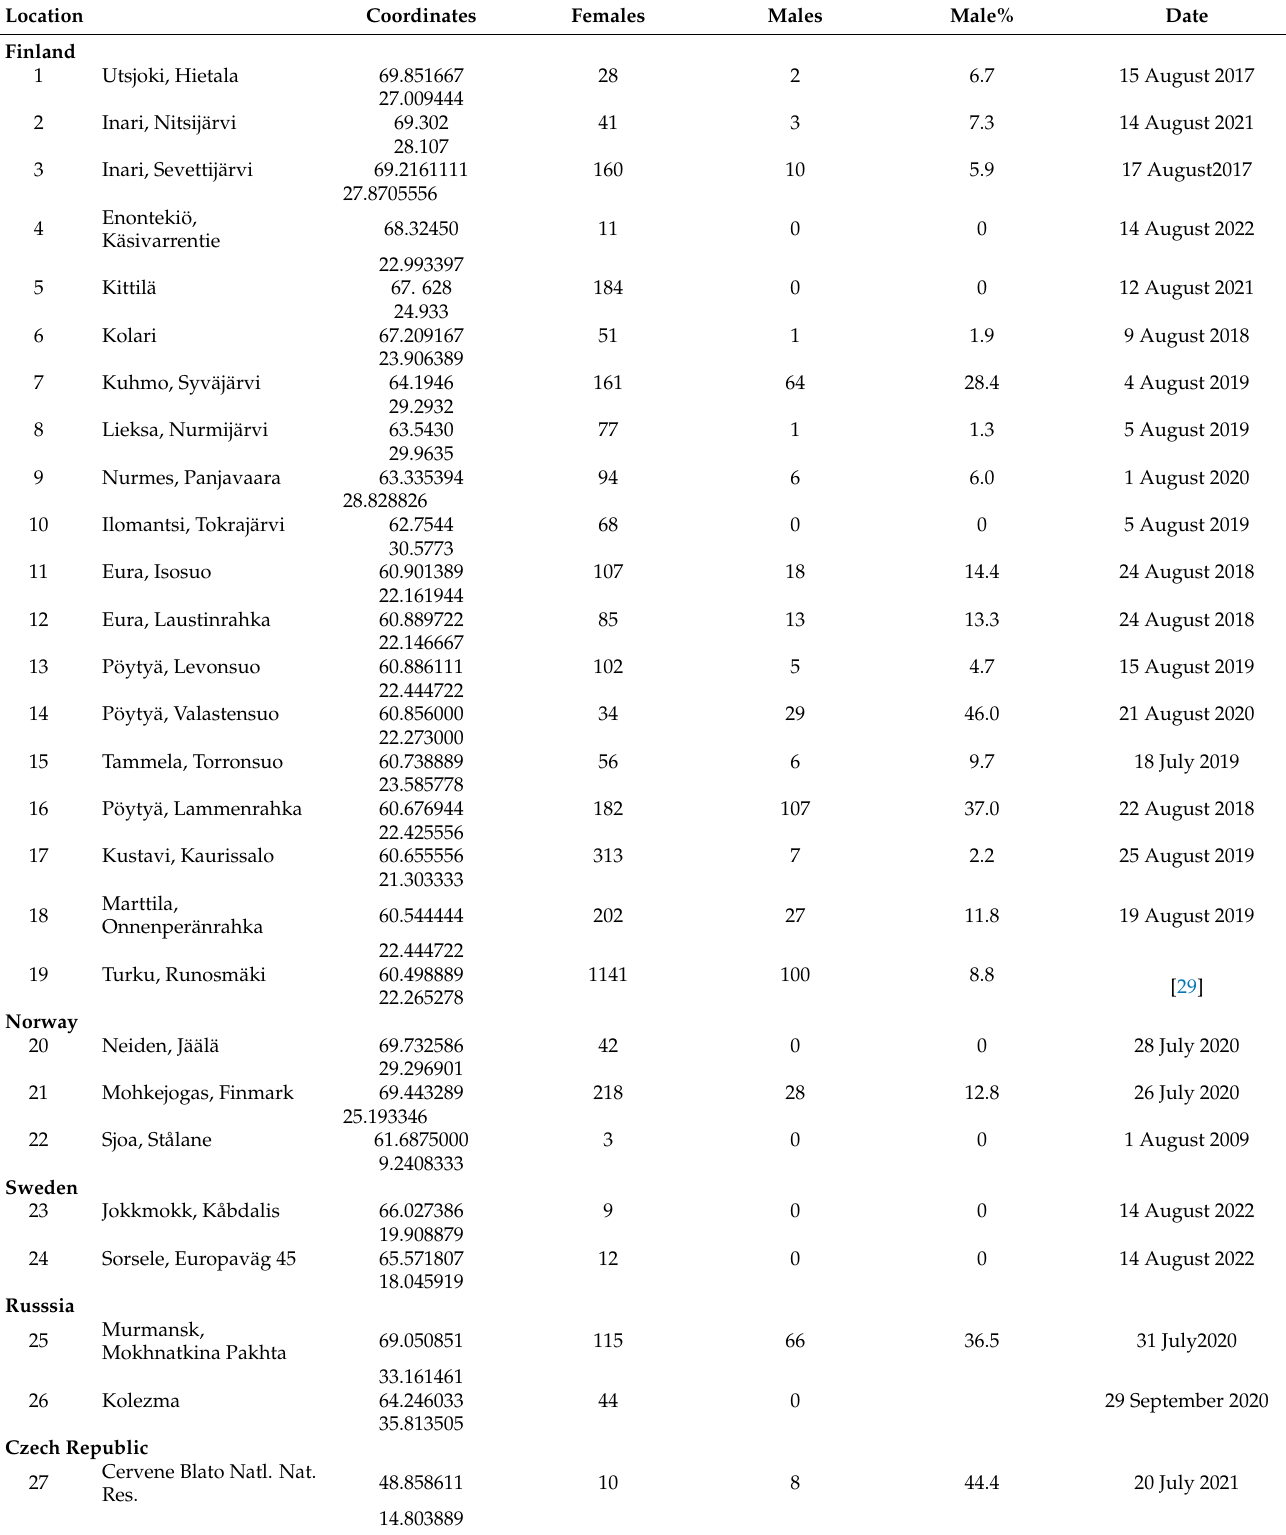
Table 1. Sampling locations, number of specimens, male frequency, and collection date of Cacopsylla ledi analyzed in the present